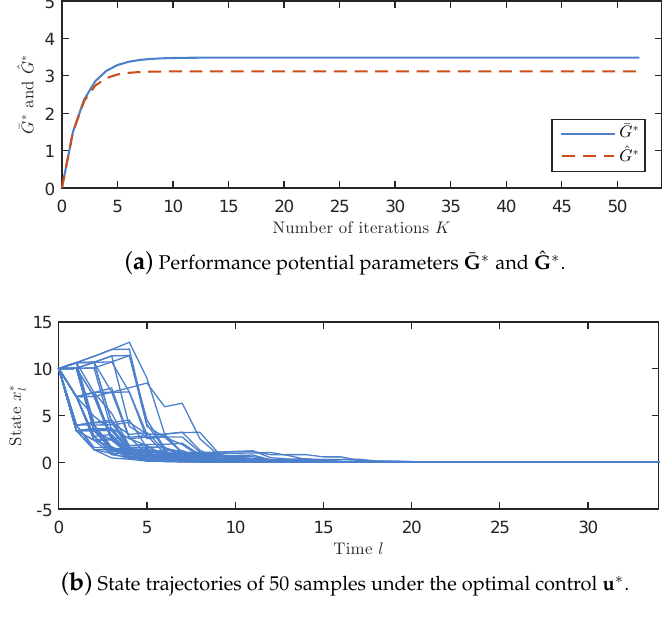
Figure 1. The simulation results of Example